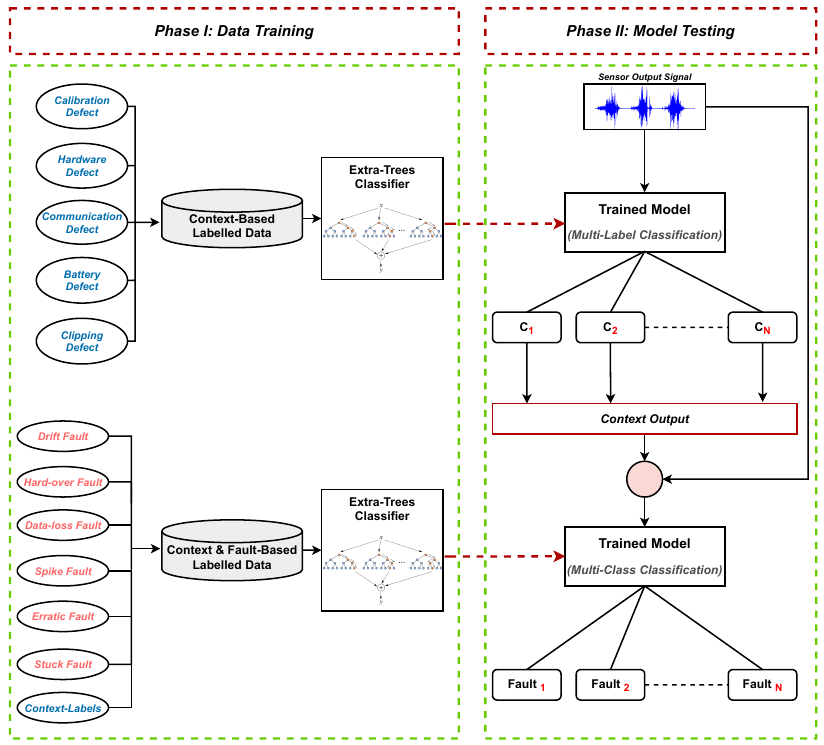
Figure 6. Framework of the proposed CAFD: the Context-Aware Fault Diagnostic